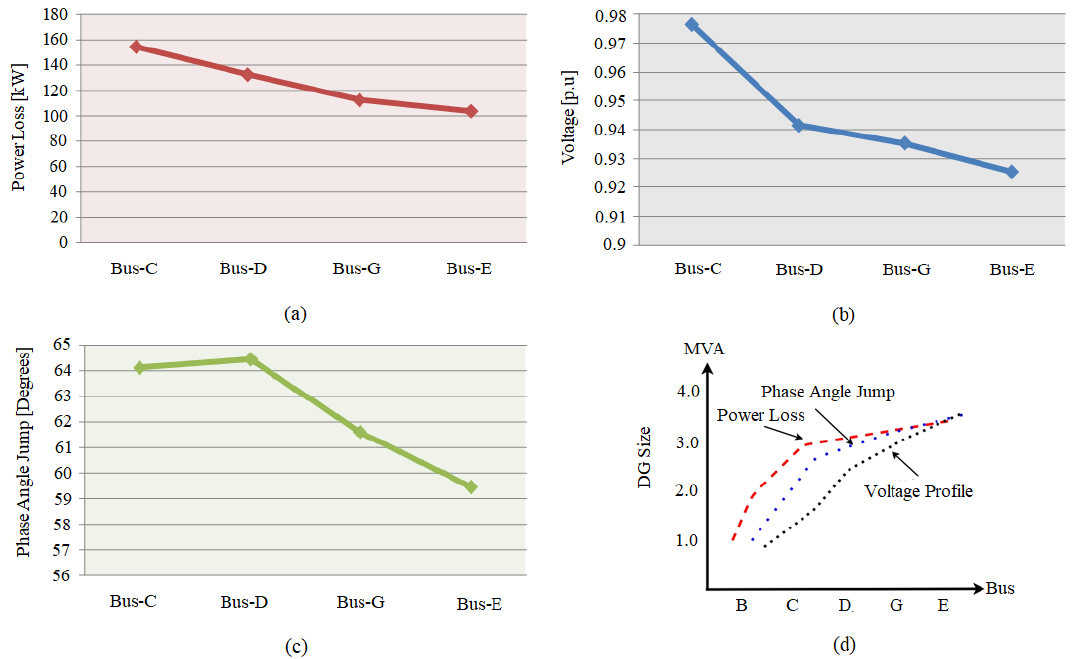
Figure 7. Characteristics of the system under the normal condition for proper placement and sizing of the new DG: ( a ) power losses at different buses, ( b ) voltage profile of the system, ( c ) Phase Angle Jump (PAJ) variations, and ( d ) GA outcome over 30